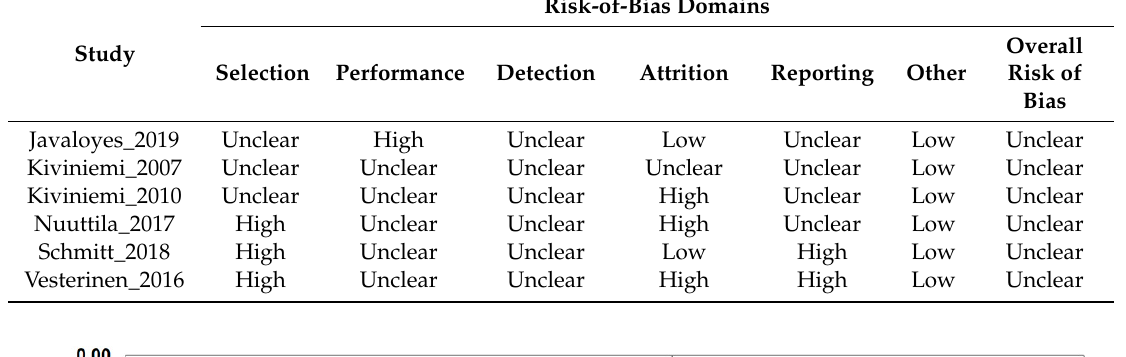
Table 2. Risk of bias in the included studies.